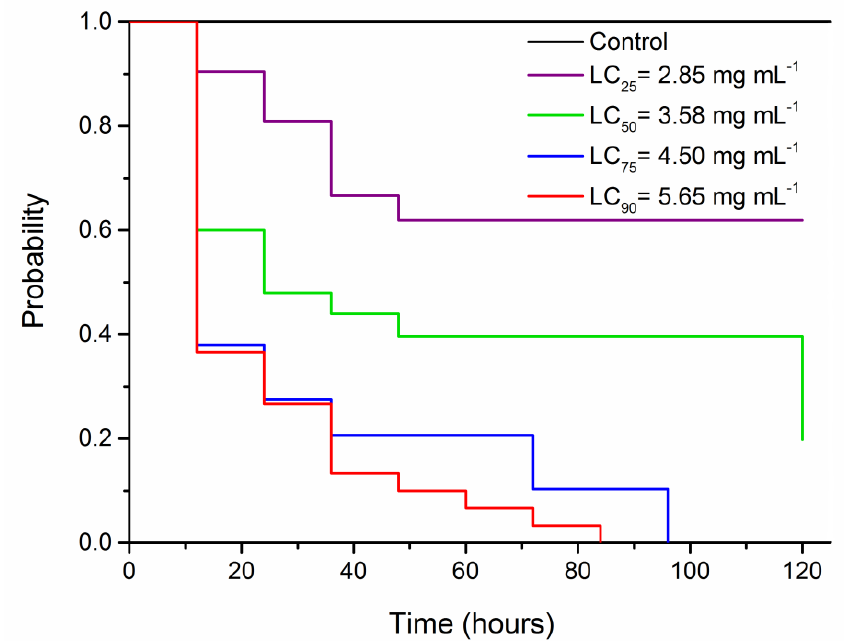
Figure 1. Survival curves of Spodoptera frugiperda caterpillars exposed to different lethal concentra-